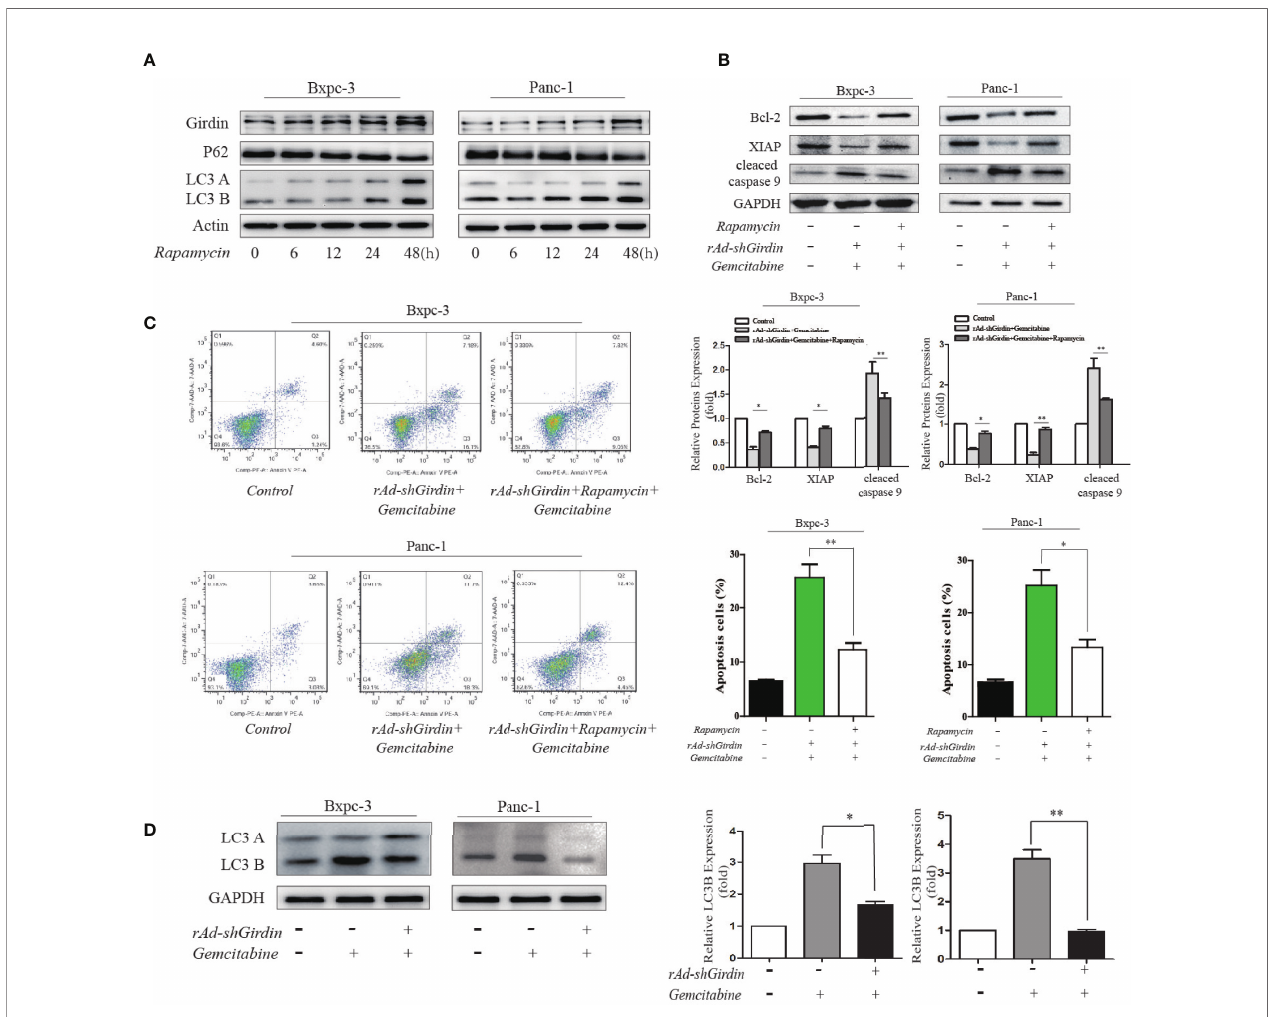
FIGURE 7 | Rapamycin-activated autophagy reversed the GEM chemosensitivity caused by the downregulation of Girdin. (A) Girdin, P62 and LC3 were detected by western blotting after cells were induced with rapamycin. Time for 0, 6, 12, 24, 48 hours after rapamycin was administered. (B) Apoptosis related proteins were detected by western blotting after cells were treated with rAd-shGirdin and GEM, and with or without rapamycin applied. The combination treatment could up- regulate the Bcl-2, XIAP and down-regulate caspase-9, while compared with the group without rapamycin. (C) Apoptosis of BxPC − 3 and PANC − 1 cells was detected by fl ow cytometer. Cells were infected with rAd-shGirdin+GEM, and subsequently treated with rapamycin, which signi fi cantly reduced apoptosis compared with the group without rapamycin in pancreatic cancer cells. (D) Western blots of BxPC-3 and PANC-1 cells were performed. Levels of the LC3B proteins were decreased in the rAd-shGirdin group. Gemcitabine was used at half the previous dose to reduce cell necrosis caused by the combination of the two drugs. Each experiment was performed 3 independent times, and all data are expressed as means ± SEM; *P < 0.05, **P <